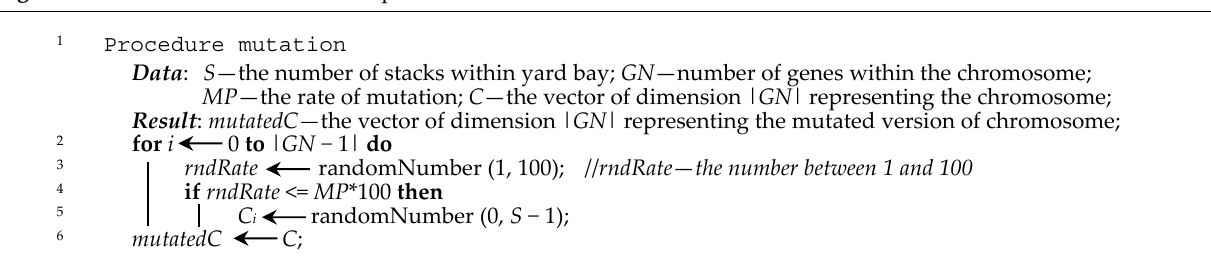
Figure 10. The one-point crossover example. Algorithm 4. Pseudo code of mutation process.